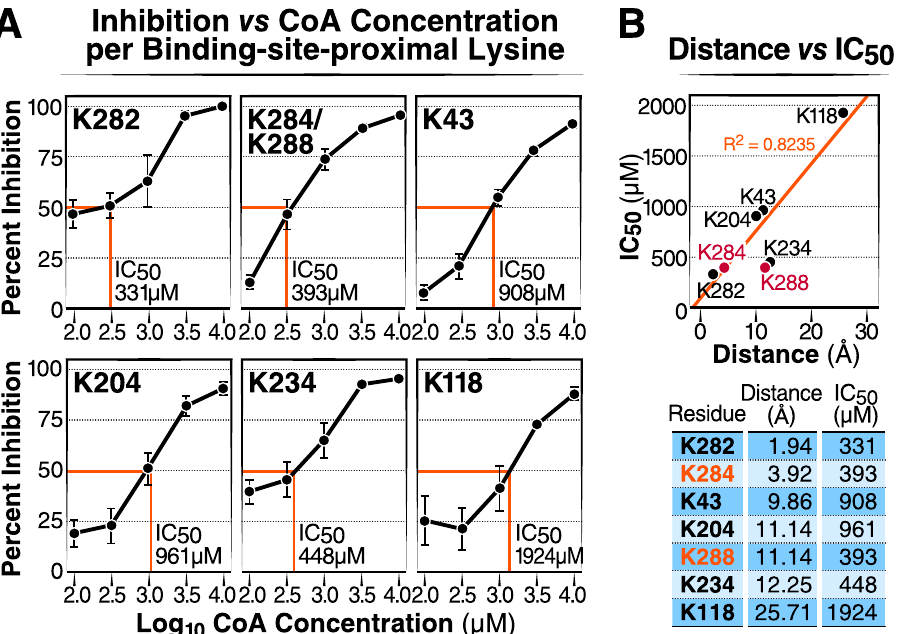
Figure 6. CoA inhibition at a particular lysine site is inversely correlated with the distance to the CoA-binding pocket. ( a ) Inhibition curve and per-residue IC 50 for CoA inhibiting the succinylation of individual lysine residues on ECHS1. ECHS1 was incubated with succinyl-CoA and increasing concentrations of CoA. Dose– response curves were expressed as the log of CoA concentration versus SuK inhibition. Percent inhibition for each residue was calculated by measuring the percent change between succinylation levels when ECHS1 was co-incubated with succinyl-CoA in the presence and absence of CoA treatment for 45 min. N = 4 per treatment. ( b ) Plot showing the correlative relationship between lysine residue distances vs the IC 50 (μM) (N = 5, R 2 = 0.8235). In the MS analysis, succinylation levels for K284 and K288 were combined as both residues were exclusively found on a shared peptide after trypsinization. As a result, these sites were not used to generate the R 2 value or trendline and are included in the graph as red